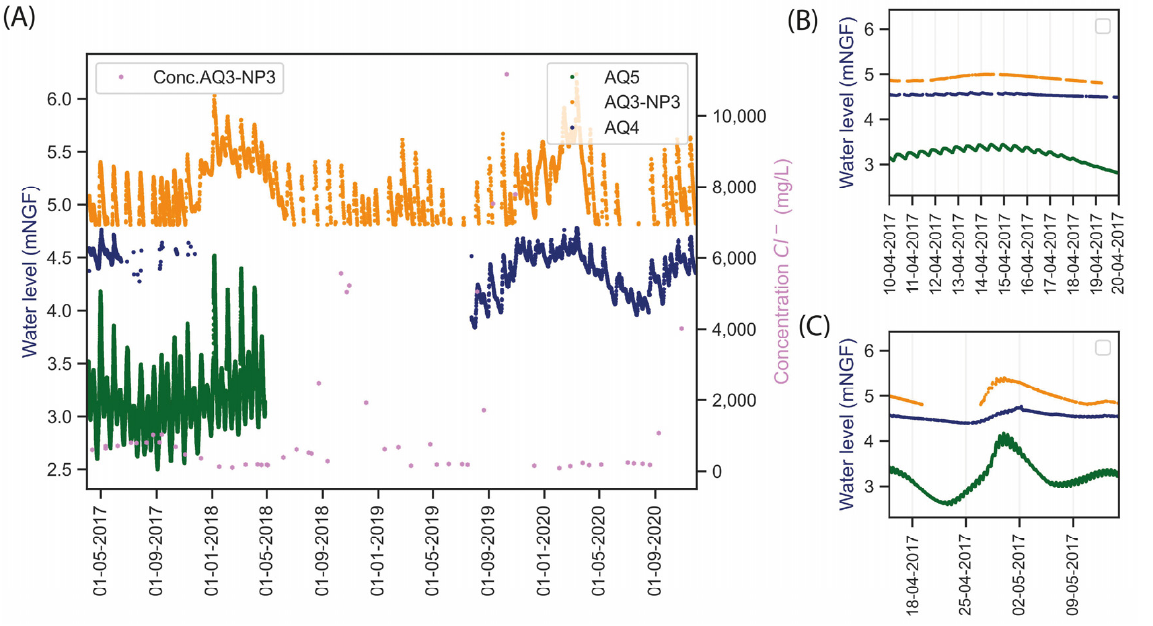
Figure 3. Potentiometric data from observation wells AQ5, AQ4, and AQ3-NP3, and Cl − concentrations in AQ3-NP3 over the period from ( A ) 1 January 2017 to 5 January 2018, ( B ) 10 April 17 to 20 April 2017, ( C ) from 15 April 2017 to 15 May 2017.